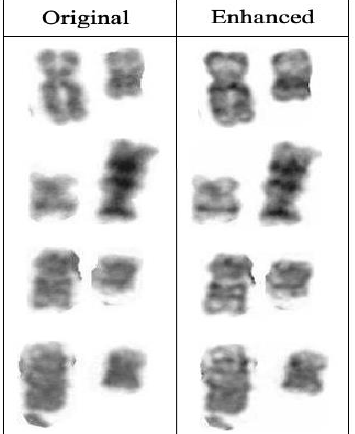
Figure 7. ChromoEnhancer Enhances the paired chromosomes with big abnormalities without com- pleting or removing the missing or extra parts, respectively.